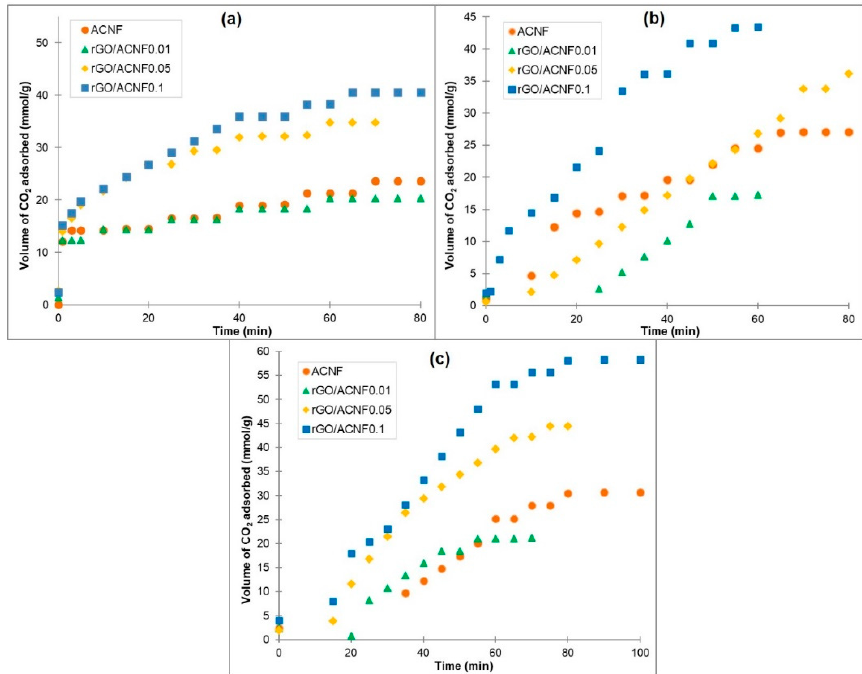
Figure 7. CO 2 uptake kinetics of the pristine ACNF and composite at different adsorption pressures ( a ) 5 bar, ( b ) 10 bar, and ( c ) 15 bar at 25 °C. Polymers 2020 , 12 , x FOR PEER REVIEW Table 2. CO 2 uptakes at different pressures at ambient temperatures.